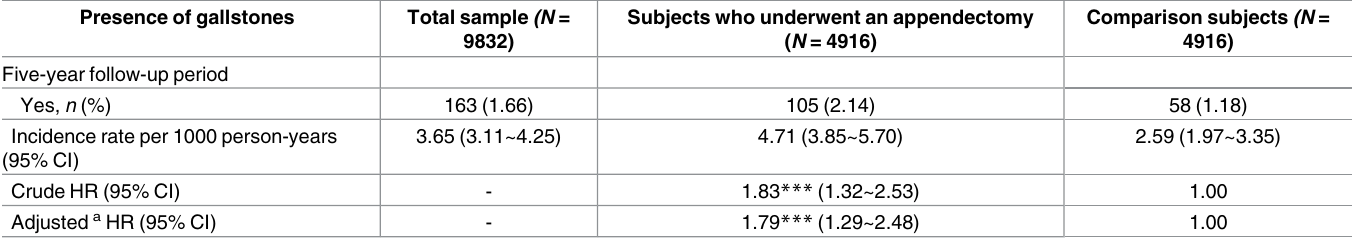
Table 2. Crude and covariate-adjusted hazard ratios (HRs) for gallstones among sampled subjects during the 5-yearfollow-up